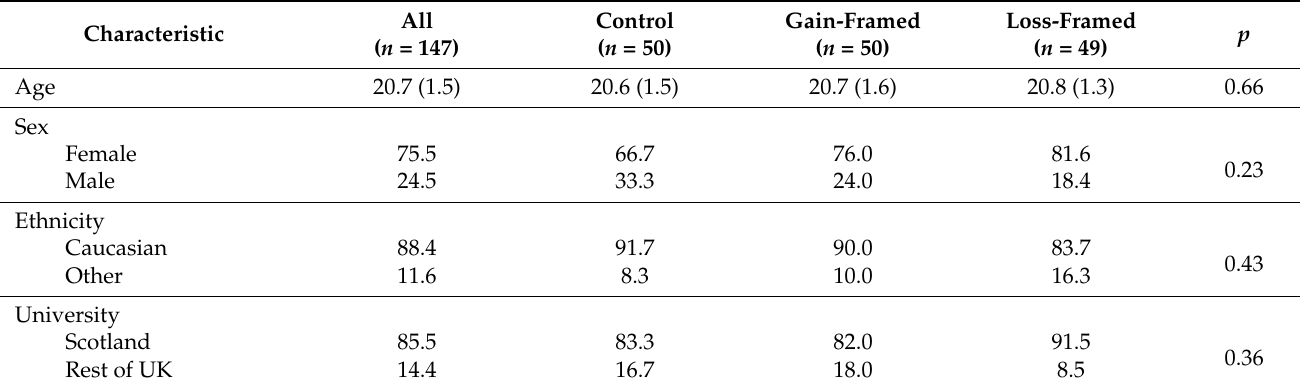
Table 2. Demographic characteristics of the sample (N = 147), age presented as the mean and standard deviation in parentheses, between-group difference assessed by ANCOVA. Other characteristics are a percentage of the sample, between- group differences assessed by chi-squared cross